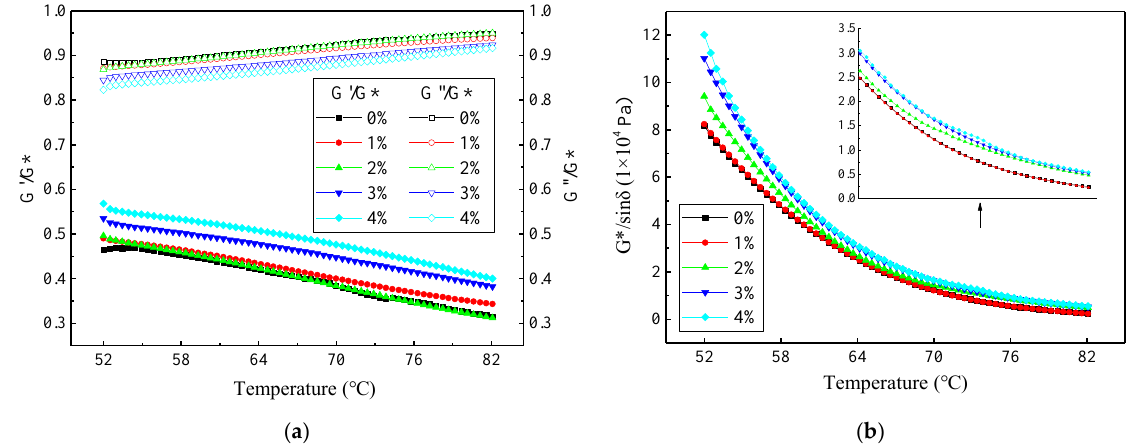
Figure 6. G’/G*, G’’/G*, and G*/sinδ of the evaporation residues for WESAE and SBRAE at different Figure 6. G (cid:48) / G*, G” / G*, and G* / sin δ of the evaporation residues for WESAE and SBRAE at di ff erent temperatures: ( a ) changes of G/G* and G’’/G*; ( b ) changes of G*/sinδ. temperatures: ( a ) changes of G / G* and G” / G*; ( b ) changes of G* / sin δ